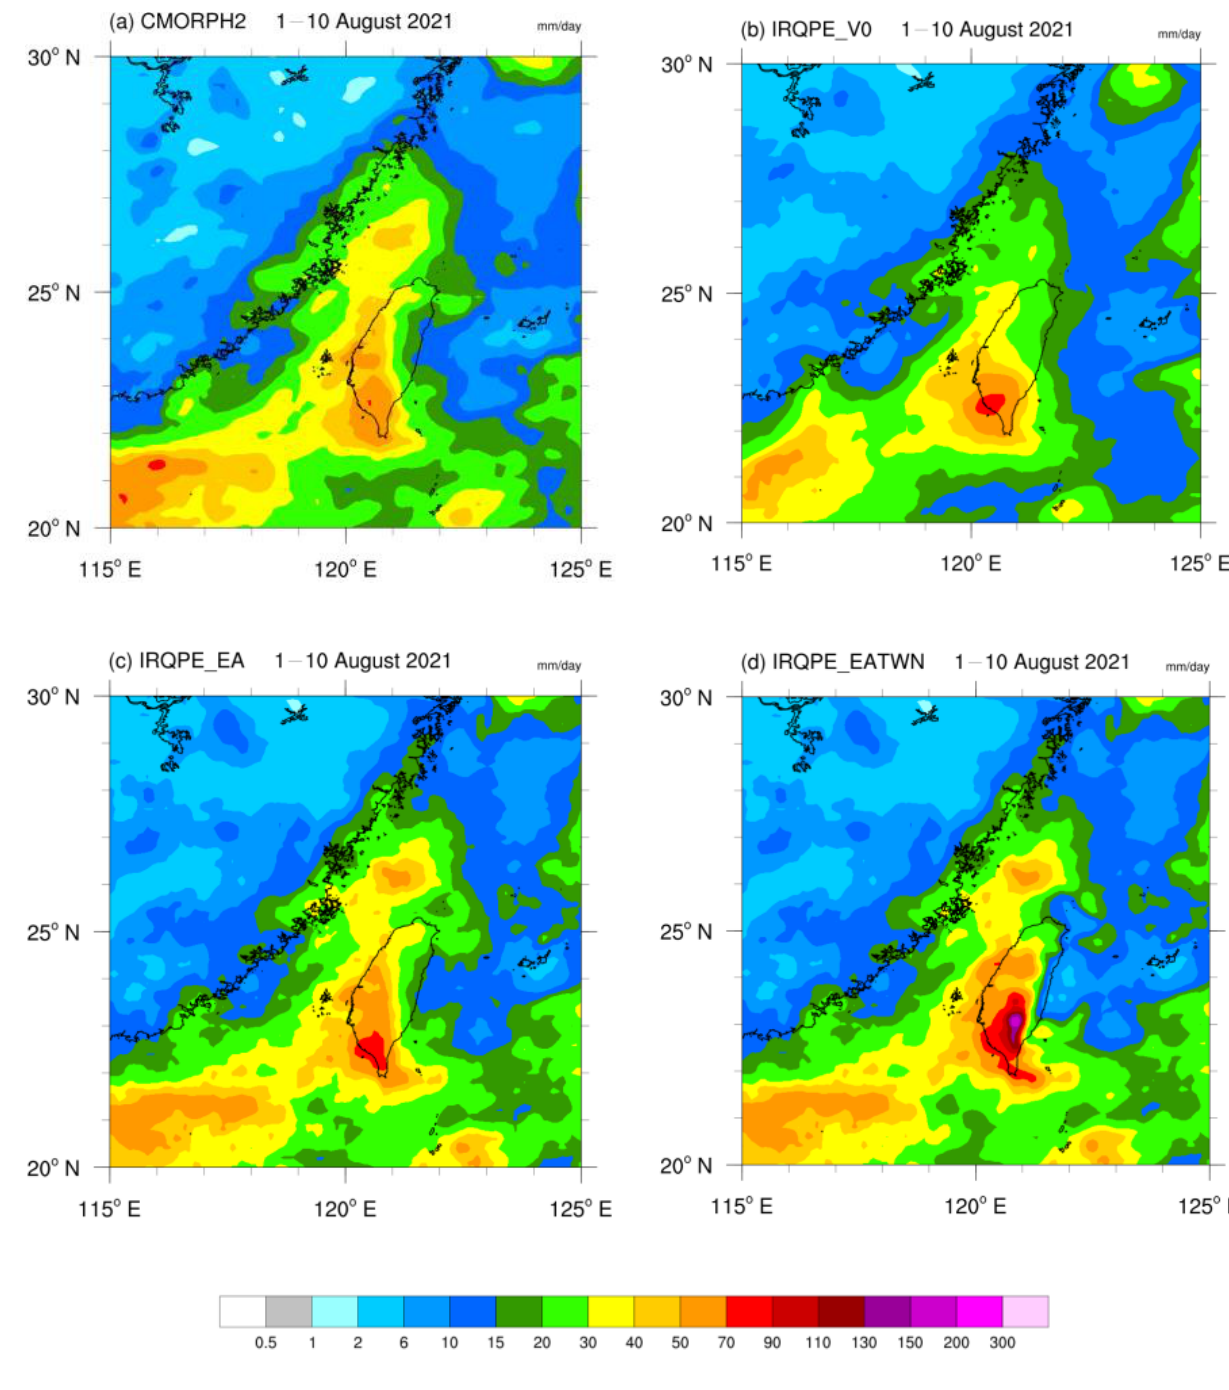
Figure 8. Ten-day mean rainfall for 1–10 AUG 2021 from ( a ) CMORPH2, ( b ) IRQPE_V0, the original version, ( c ) IRQPE_EA, the version changes the look-up table in 0.2° lat/lon gridbox. ( d ) IRQPE_EATWN, merging IRQPE_EA with IRQPE_TWN .